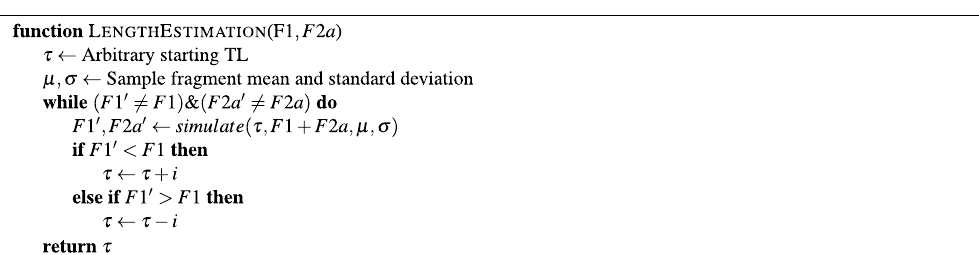
Algorithm 1. Telomerecat length estimation simulation